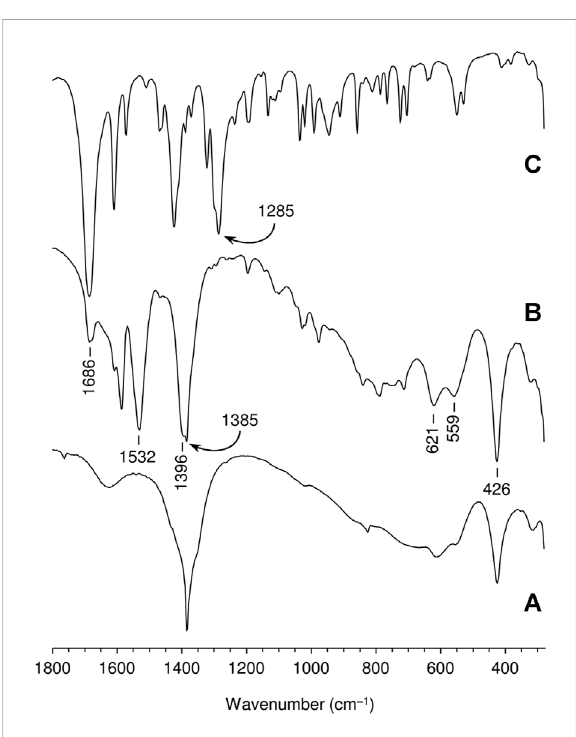
FIGURE 3 FT-IR spectra in the range 280 – 1800 cm − 1 of (A) LDH-NO 3 , (B) LDH-KDA3, and (C) ketodiacid 3 . The frequencies of selected bands are